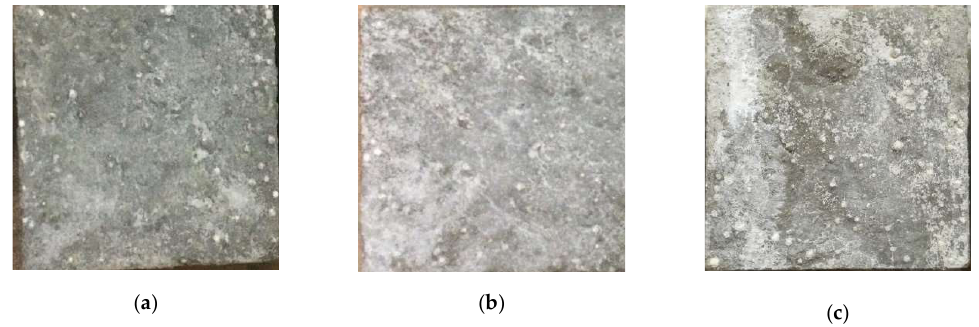
Figure 11. The surface of structural EPS concrete of group B after W-D cycles: ( a ) 90 cycles; ( b ) 120 cycles; ( c ) 150 cycles.